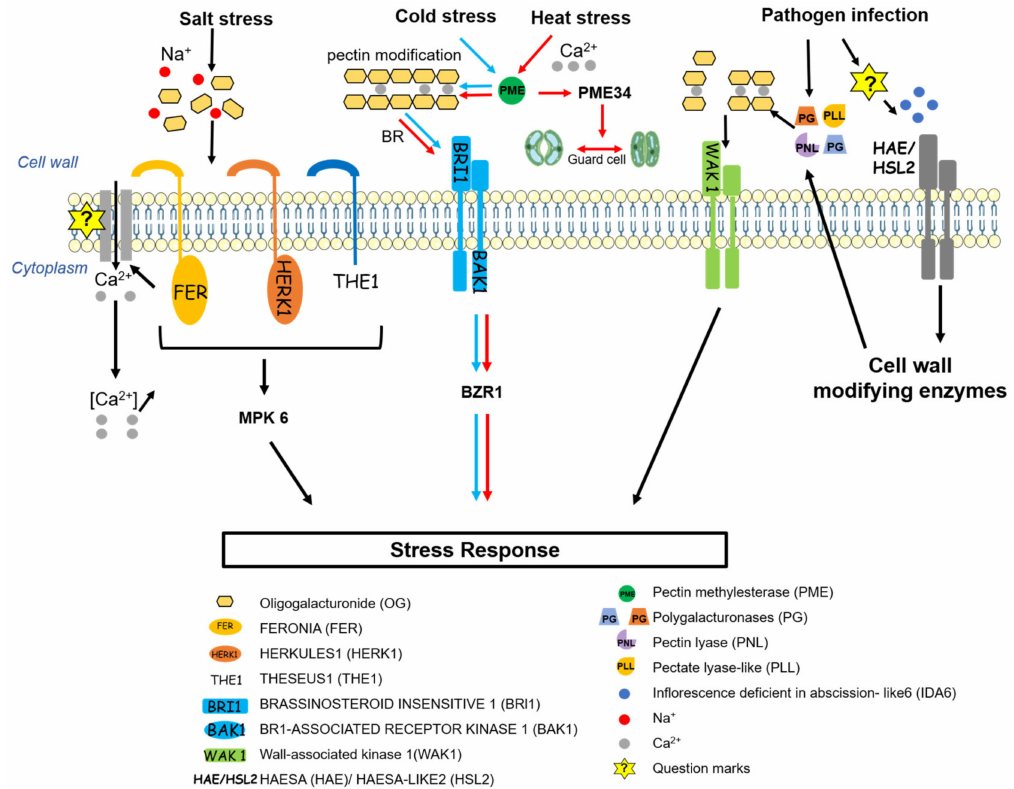
Figure 2. The roles of pectin in signaling processes during interactions with the environment. Salt stress affects the cell wall because sodium ions disrupt pectin crosslinking. The cell wall sensor FERONIA (FER), in combination with HERKULES1 (HERK1) and THESEUS1 (THE1), senses salinity through its pectin-binding extracellular domain, leading to an increase in cytosolic [Ca 2+ ] and mitogen-activated protein kinase 6 (MPK6) function, which are required for salt-induced gene expression. Cold stress induces the expression of pectin methylesterase (PME) and modulates the rigidity of the cell wall via brassinosteroid (BR) signaling. BR molecules are perceived by BRI1, triggering the formation of BRI1-BAK1, which initiates an intracellular phosphorylation relay cascade and activates BZR1. Heat stress in combination with Ca 2+ increases the rate of demethylesterification via PME activity. PME34 is involved in regulating stomatal aperture during heat stress. During pathogen infection, pectin is degraded to produce oligogalacturonides (OGs), which are detected by wall-associated kinase 1 (WAK1), leading to a strong immune response. The pathogen secretes polygalacturonase (PG), pectin lyase (PNL) and pectate lyase-like (PLL) to degrade pectin and attempt infection. It also regulates IDL6 expression and the downstream HAE/HSL2 pathways to produce pectin-degrading enzymes from the host. Question marks represent an unknown receptor, MPK, or transcription